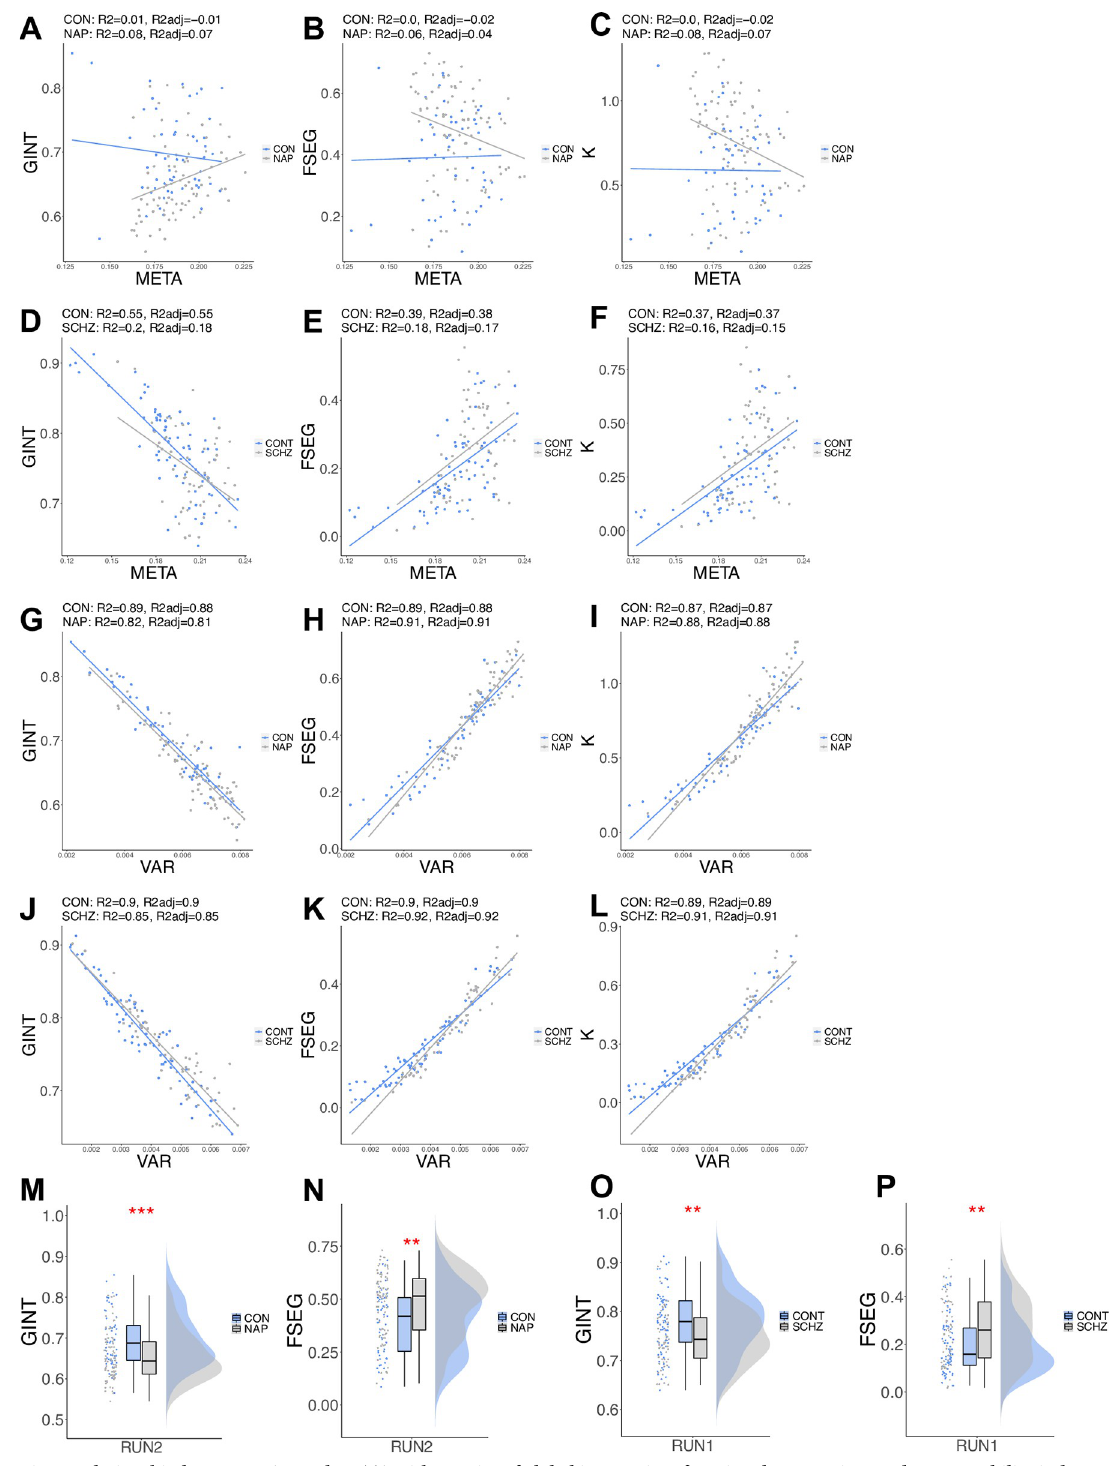
Fig 8. Relationship between VAR and META with metrics of global integration, functional segregation, and a metastability index K. A) HCPEP global integration versus META. B) HCPEP functional segregation versus META. C) HCPEP Metastability Index versus META. D) Cobre global integration versus META. E) Cobre functional segregation versus META. F) Cobre Metastability Index versus META. G) HCPEP global integration versus VAR. H) HCPEP functional segregation versus VAR. I) HCPEP Metastability Index versus VAR. J) Cobre global integration versus VAR. K) Cobre functional segregation versus VAR. L) Cobre Metastability Index versus VAR.